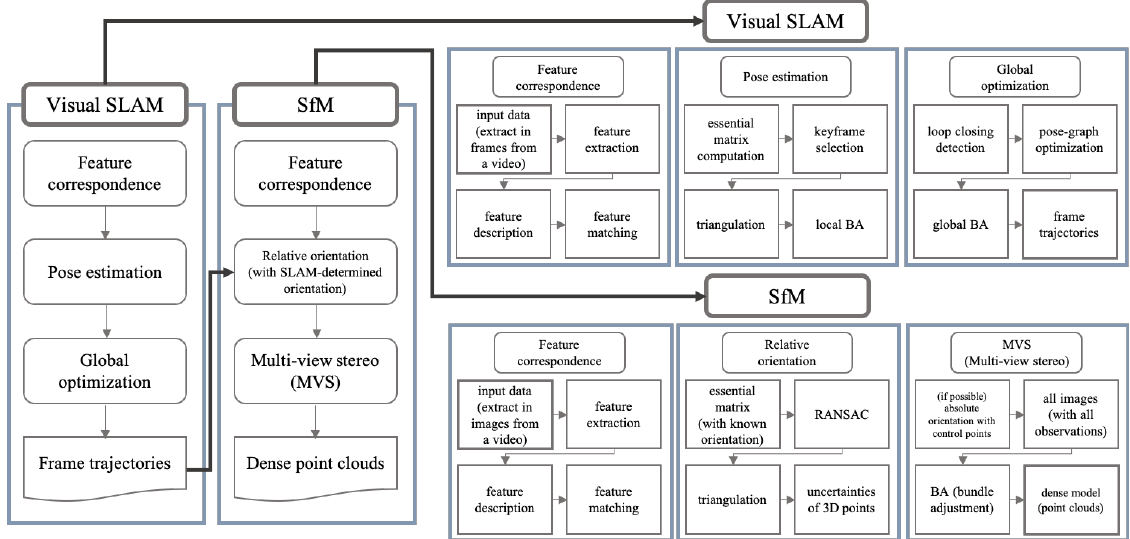
Figure 1. SfM with SLAM-determined